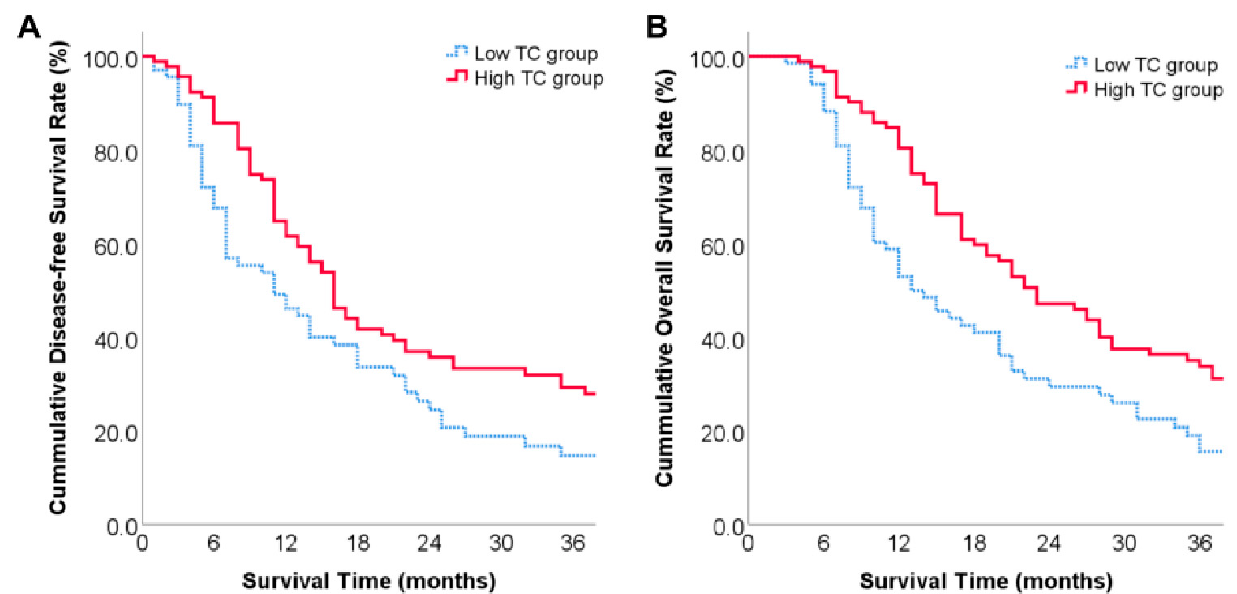
Figure 6. Long-term prognosis of low-TC group and high-TC group: ( A ) overall disease-free survival rate of low-TC group and high-TC group; ( B ) overall survival rate of low-TC group and high-TC group.